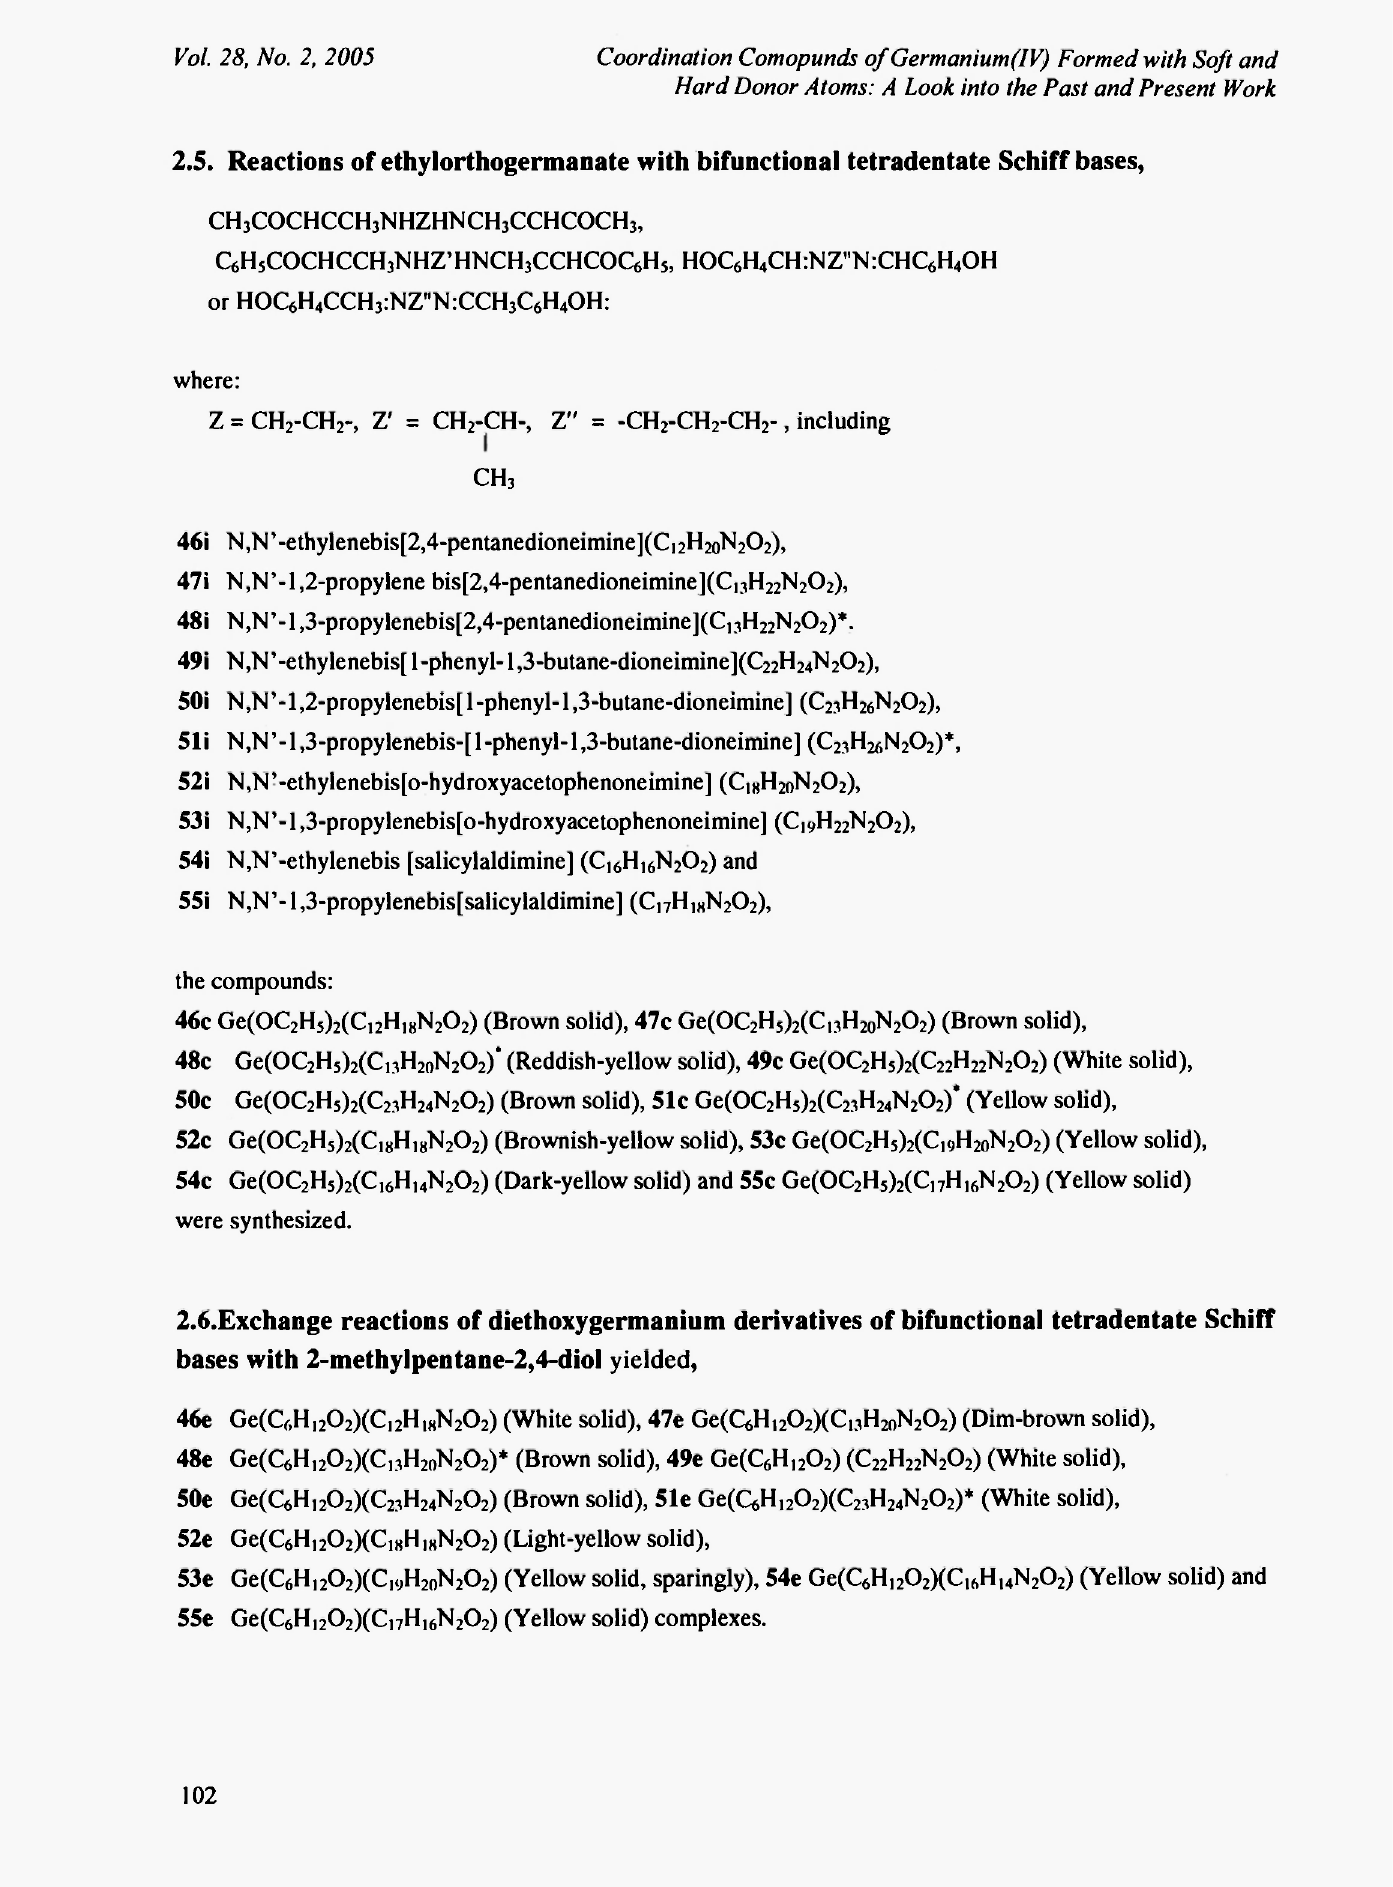
2.5. Reactions of ethylorthogermanate with bifunctional tetradentate Schiff bases,